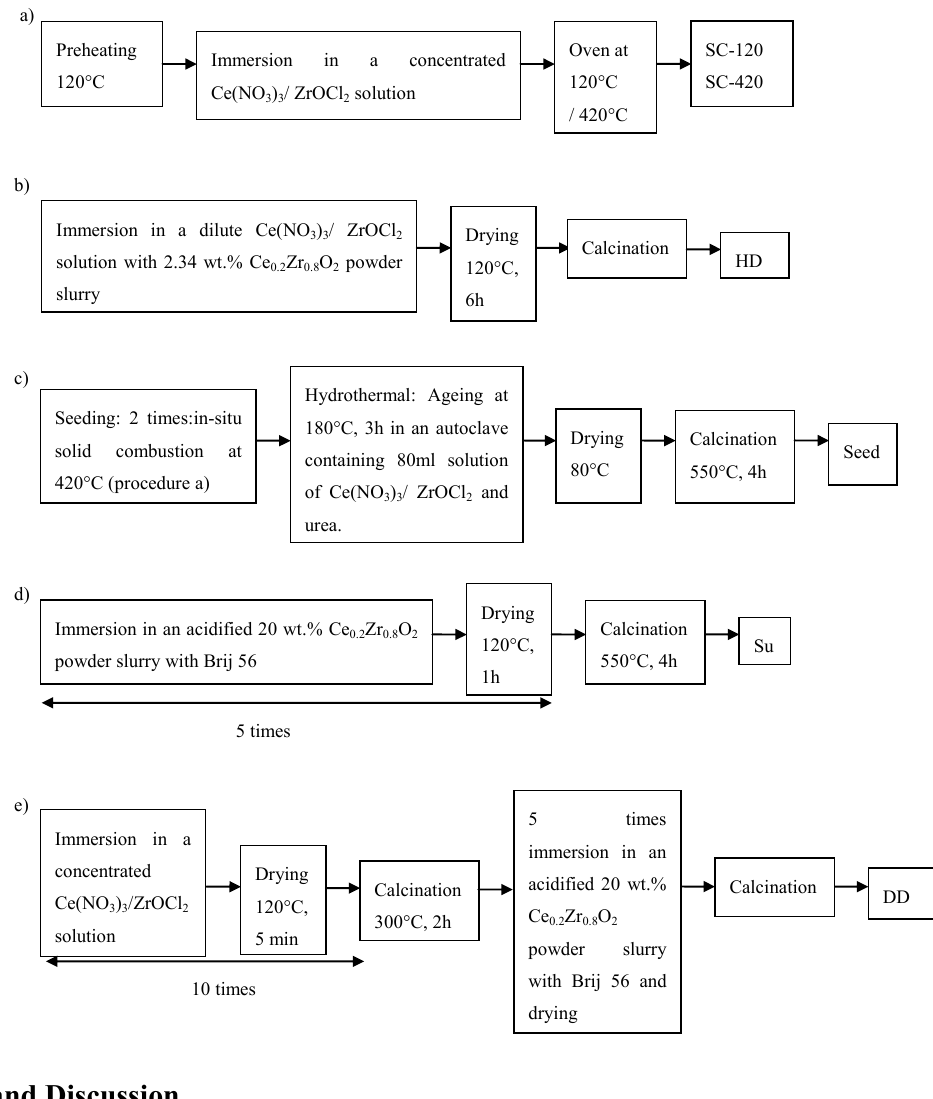
Figure 1. Deposition methods of Ce solid combustion; ( b ) Hybrid deposition; ( c ) Secondary growth on Ce ( d ) Suspension; ( e ) Double deposition combining wet impregnation and